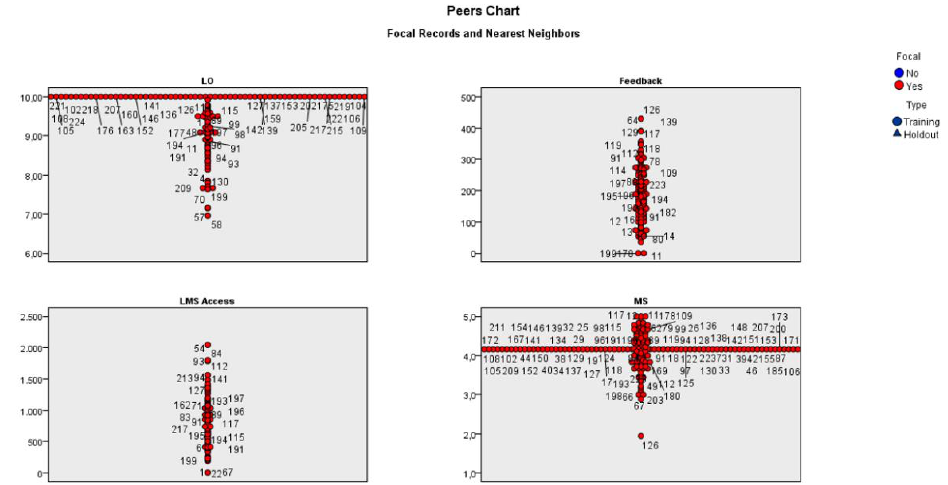
Figure 4. k-nn focal analysis of LO, feedback, LMS access, and student satisfaction. Note: LO = learning outcomes; feedback = access to automatic feedback resources; MS = mean student satisfaction with teaching.